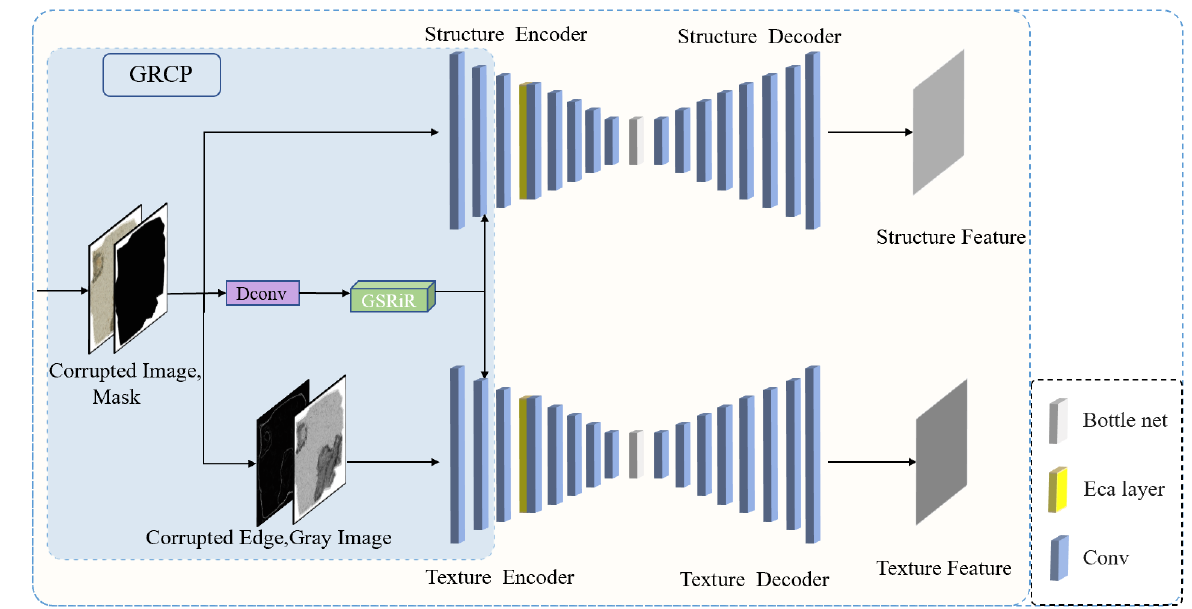
Figure 3. Overall generator